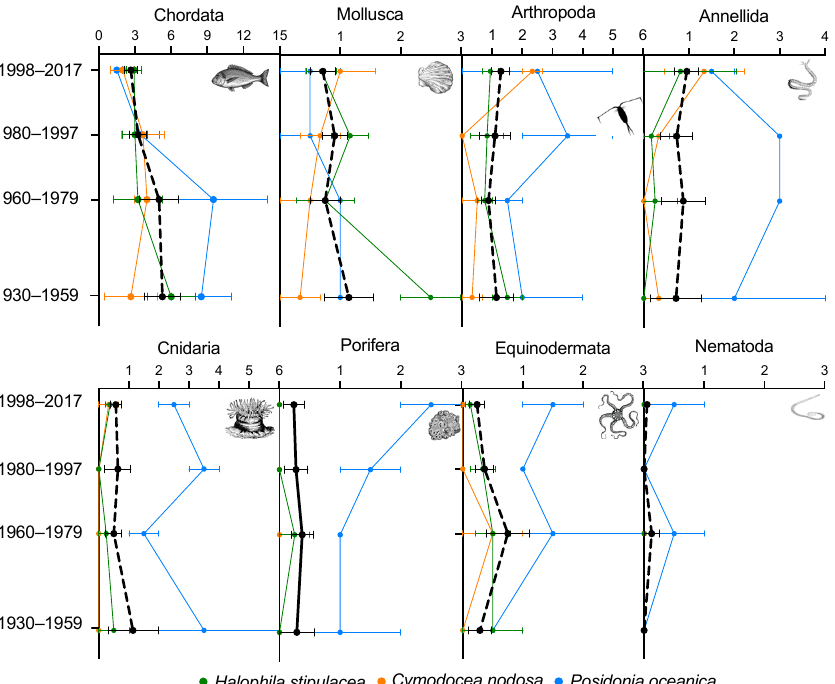
Figure 2. Temporal changes in richness (mean ± SE) in eight metazoan phyla within seagrass sediments ( H. stipulacea in green; C. nodosa in orange; P. oceanica in blue; overall of the three seagrass species in black) from the eastern Mediterranean Sea (Greece and Cyprus). Solid dark lines indicate significant differences between time intervals and dashed dark lines indicate non-significant differences ( p < 0.003 after Bonferroni correction), considering the three seagrass species combined. The Phylum Cnidaria also did not show differences in richness through time, but at